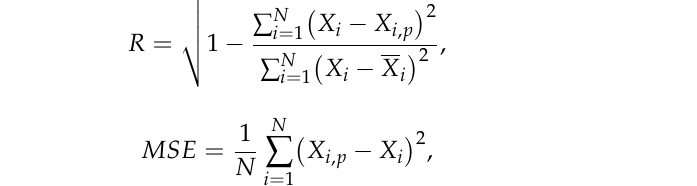
Figure 2. The structure of ANN model designed in the present work.